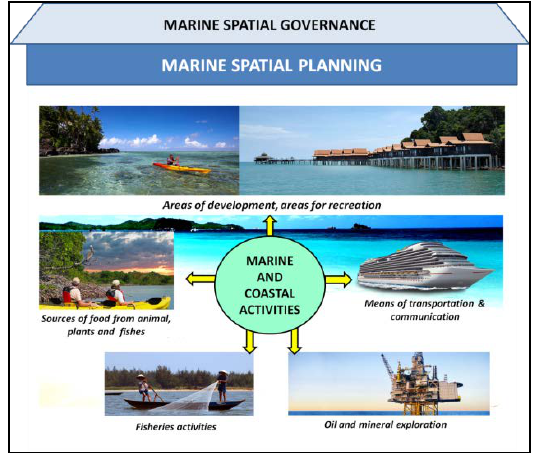
Figure 1. Marine and Coastal Activities that relates to Marine Spatial Planning and Marine Spatial Governance Hence, the need to have a marine policy towards governing the spatial information has been highlighted by most of the nation. Since there is no policy and strategic plans on implementing the marine spatial planning, it caused to overlapping of jurisdiction among most of the institutions that involve with marine activities as stated in Figure 1. Therefore, the priority is focus on mapping out the marine institutions arrangement towards sustaining the marine spatial planning